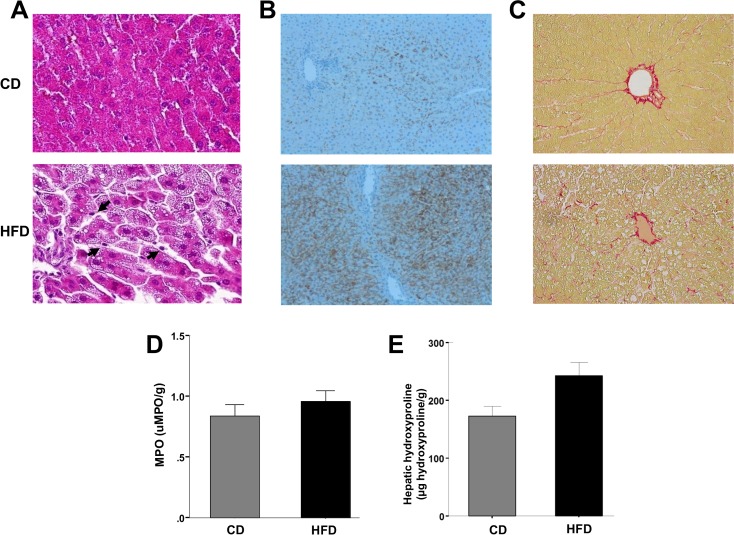
Liver steatosis, inflammation and fibrosis evaluation.(A) Representative histological images of liver tissue stained with hematoxilin-eosin (x40) of CD (Top) and HFD (Bottom) rats. Livers of HFD rats showed significant microvesicular steatosis, compared with CD rats. Few inflammatory cells were observed (Arrows). (B) Liver slices (x20) showing high content of adipophilin in HFD liver rats (Bottom) as compared with CD rats (Top). (C) Sirius-red staining (x20) of CD (Top) and HFD (Bottom) rats. Similar grade of fibrosis was observed. (D) Evaluation of myeloperoxidase (MPO) activity. A similar content of MPO was observed in CD (n = 6) and HFD (n = 11) rats. (E) Evaluation of hepatic hydroxyproline content. A similar content of hydroxyproline was observed in CD and HFD rats (n = 5, in each group). Values are mean ± SEM.